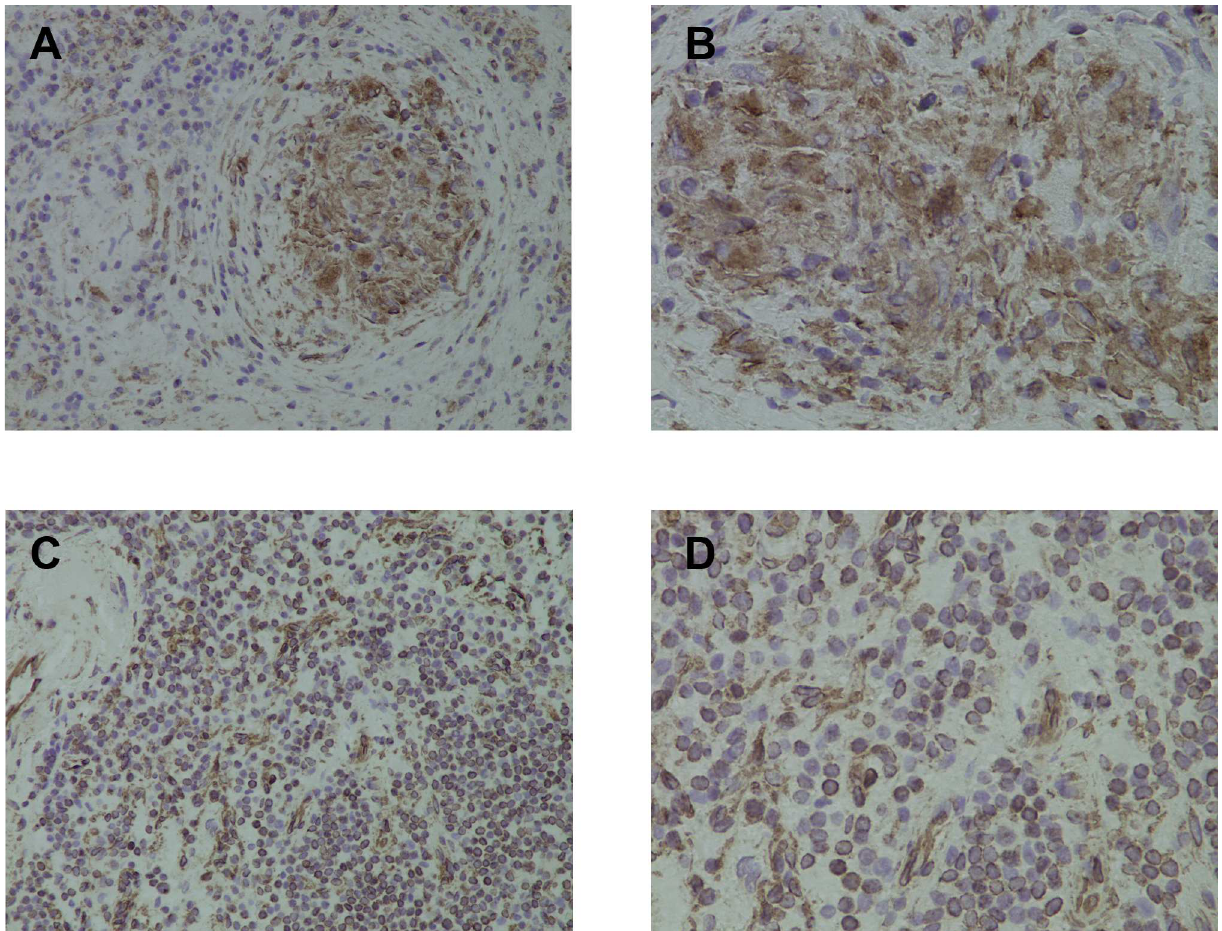
Fig 4. Immunohistochemicalstaining of spleentissue shows increasedabundanceof vimentin in sarcoidosis spleensat 200 x (Fig 4a) and 400 x magnification (Fig 4b) comparedto healthyspleen tissue at the same magnifications (Fig 4c and